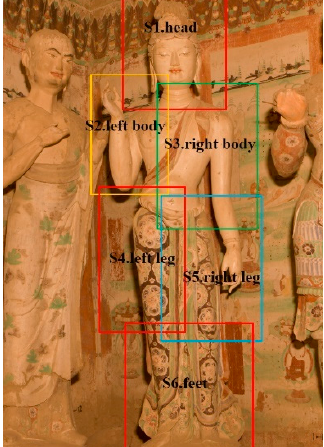
Figure 3. Stations planned for right Bodhisattva.